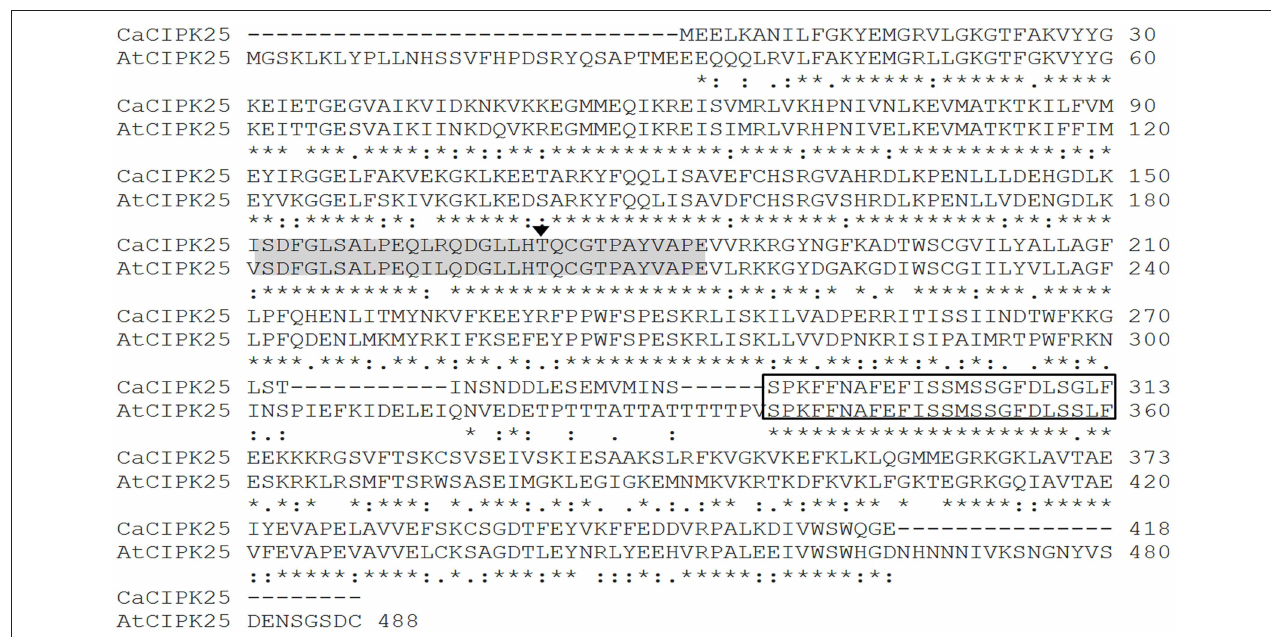
FIGURE 1 | Protein sequence alignment of AtCIPK25 and its ortholog CaCIPK25 in chickpea using ClustalW. The activation loop is shown in shaded region with the conserved threonine residue marked with an arrow. The NAF/FISL module responsible for interaction with CBL is shown in box.